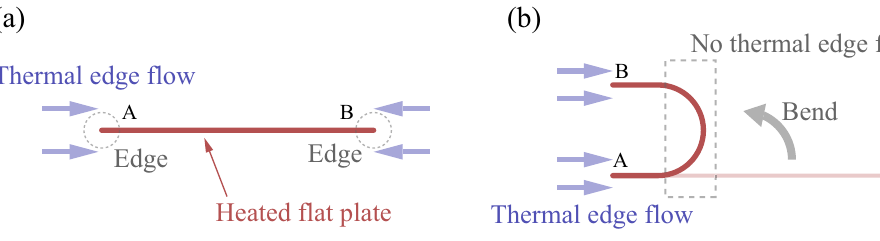
Figure 1. Schematics of the concept. ( a ) A uniformly heated flat plate. A thermal edge flow is induced at each tip (i.e., edge) in the direction depicted in the figure, resulting in no net flow. ( b ) A uniformly heated U-shaped body. The tips A and B induce thermal edge flows in the same direction, leading to a rightward net flow. Note that the curved part is unlikely to induce a thermal edge